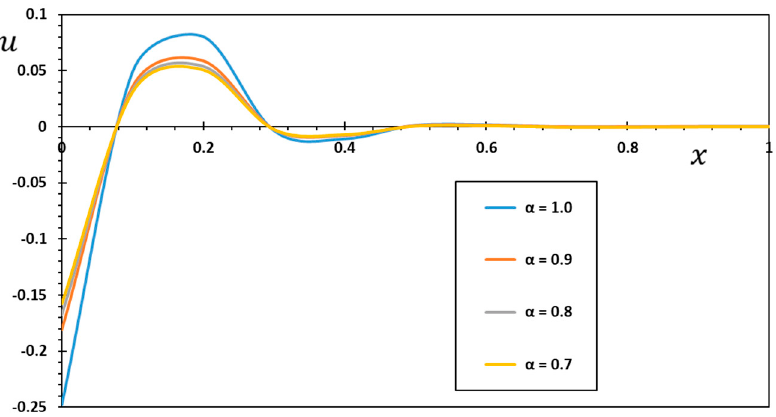
Figure 4. Effect of fractional order, 𝜶 , on the displacement, 𝒖 .